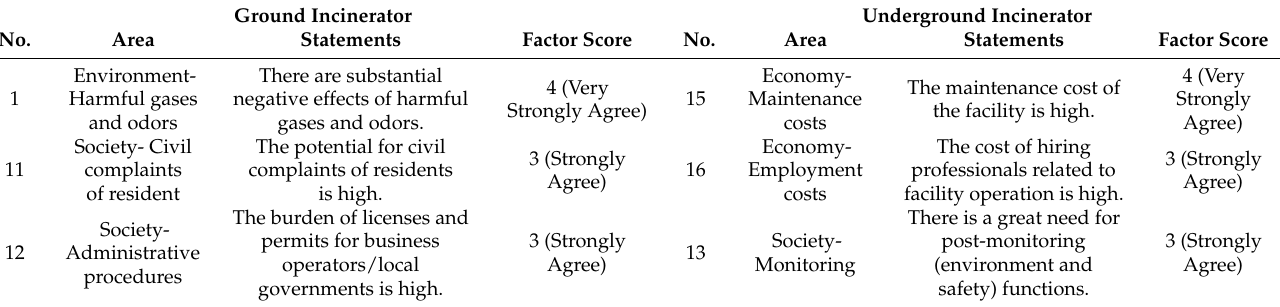
Table 5. Main statements of Factor 1